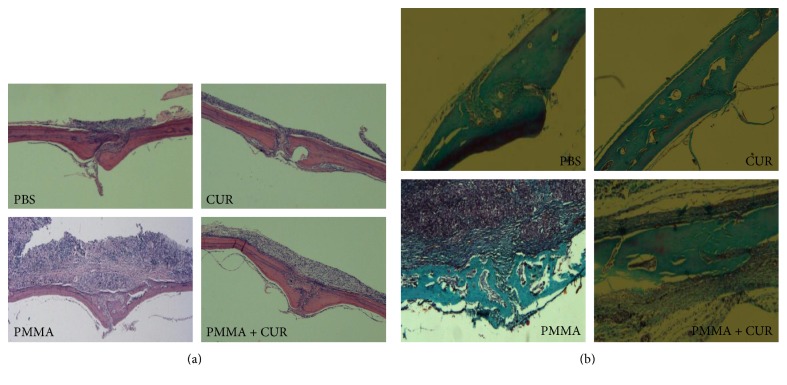
Curcumin prevented PMMA particle-induced mouse calvarial osteolysis. (a) Representative hematoxylin and eosin (H&E) staining of calvarial sections in each group (N = 6/group). (b) Representative Masson trichrome staining of calvarial sections in each group (N = 6/group).